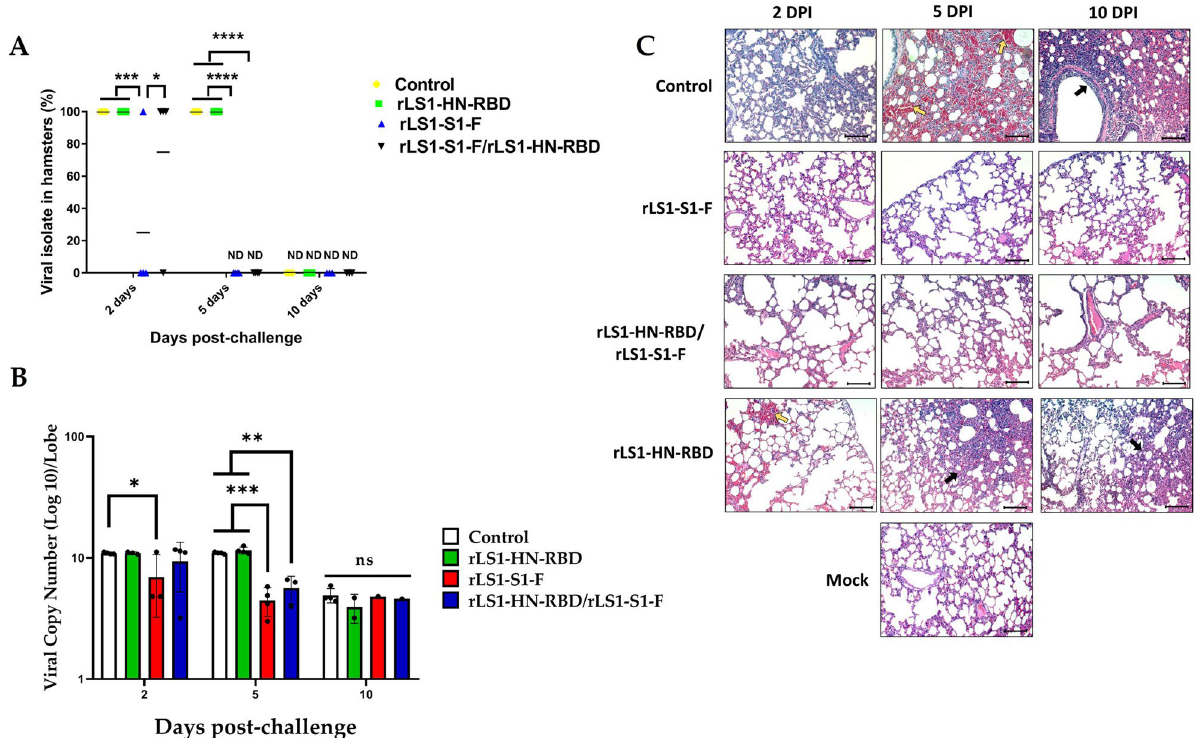
Figure 6. Efficacy of live NDV vaccines against SARS-CoV-2 infection in hamsters. Golden Syrian hamster groups vaccinated with rLS1-S1-F, rLS1-HN-RBD, the mixture rLS1-S1-F/rLS1-HN-RBD, or non-vaccinated (positive control) were challenged 30 days after the boost with SARS-CoV-2, along with a mock group that was non-vaccinated nor challenged (negative control). ( A ) Viral isolation (% of animals that were positive for SARS-CoV-2) was done from the lung of each hamster group ( n = 4) at days 2, 5, and 10 post-challenge. Two-way ANOVA and Tukey’s post hoc were performed. * P < 0.05; ** P < 0.01; *** P < 0.001; **** P < 0.0001. ( B ) Detection by RT-qPCR of SARS-CoV-2 in culture supernatant of Vero cells, inoculated with lung homogenates of immunized and challenged hamster groups. The data show a significant difference in the viral copy number * P < 0.05; ** P < 0.01; *** P < 0.001; **** P < 0.0001. ns, not significant. ( C ) Lung histopathology of each hamster group (n = 4) was euthanized at different days post-infection (DPI). Hemorrhagic and infiltrated areas are indicated by a yellow and black arrow, respectively. Image amplitude: 20×. Scale-bar: 100 candidate vectored in NDV exposing the complete S antigen (S1 and S2 domains) demonstrated protection of hamsters in a challenge assay 38,39 . Of note, hamsters from the non-vaccinated group that were challenged with SARS-CoV-2 positive virus cul- tures at 2 and 5 dpc were negative at day 10. These results are in agreement with previous studies which showed that viral load is reduced to undetectable levels by 8 days after infection in the hamster model 41,42 . Along with the in vitro results, the IFA also confirmed that the S1 subunit vaccine, followed by the combined rLS1-HN-RBD/ rLS1-S1-F vaccine, induced the strongest protective responses. This was evidenced by failure to isolate virus from the lung tissue at 5 dpc. At 2 dpc, only half of the animals vaccinated with the S1 subunit vaccine had virus isolated, and these had a negative IFA. This suggests that neutralization of SARS-CoV-2 is likely to be occurring between 2 and 3 dpc in the hamster model. Histopathological evaluation of lung from non-vaccinated hamsters after the challenge showed severe patho- logical signs of the disease, beginning with interstitial pneumonia 2 dpc, and ending in severe bronchopneumo- nia, as well as the loss of alveolar architecture. In contrast, the groups immunized with the S1 subunit and RBD domain/S1 subunit were protected, showing almost intact alveoli and respiratory capillaries, without evidence of an inflammatory reaction. However, the animals vaccinated with the RBD domain vaccine developed pathologi- cal lesions, although with a lesser hemorrhagic degree than the non-vaccinated control group, with pneumonia at 2 dpc and ending in a moderate to severe pneumonia at 10 dpc. This is an encouraging result that needs to be verified in human clinical trials. After intranasal challenge, the animals were tested for presence and viability of SARS-CoV-2 in the lungs, at days 2, 5 and 10, time at which animals were sacrificed and necropsied. At day 5 after the challenge, animals vaccinated with rLS1-S1-F and rLS1-S1-F/rLS1-HN-RBD did not show the presence of viable virus in the lungs, in contrast to the control and the vaccinated with rLS1-HN-RBD animals. However, since we did not measure the virus shedding from the nasal cavity, we can’t speculate that virus shedding could be stopped in the vaccinated animals. Further studies are needed to better understand this fact.